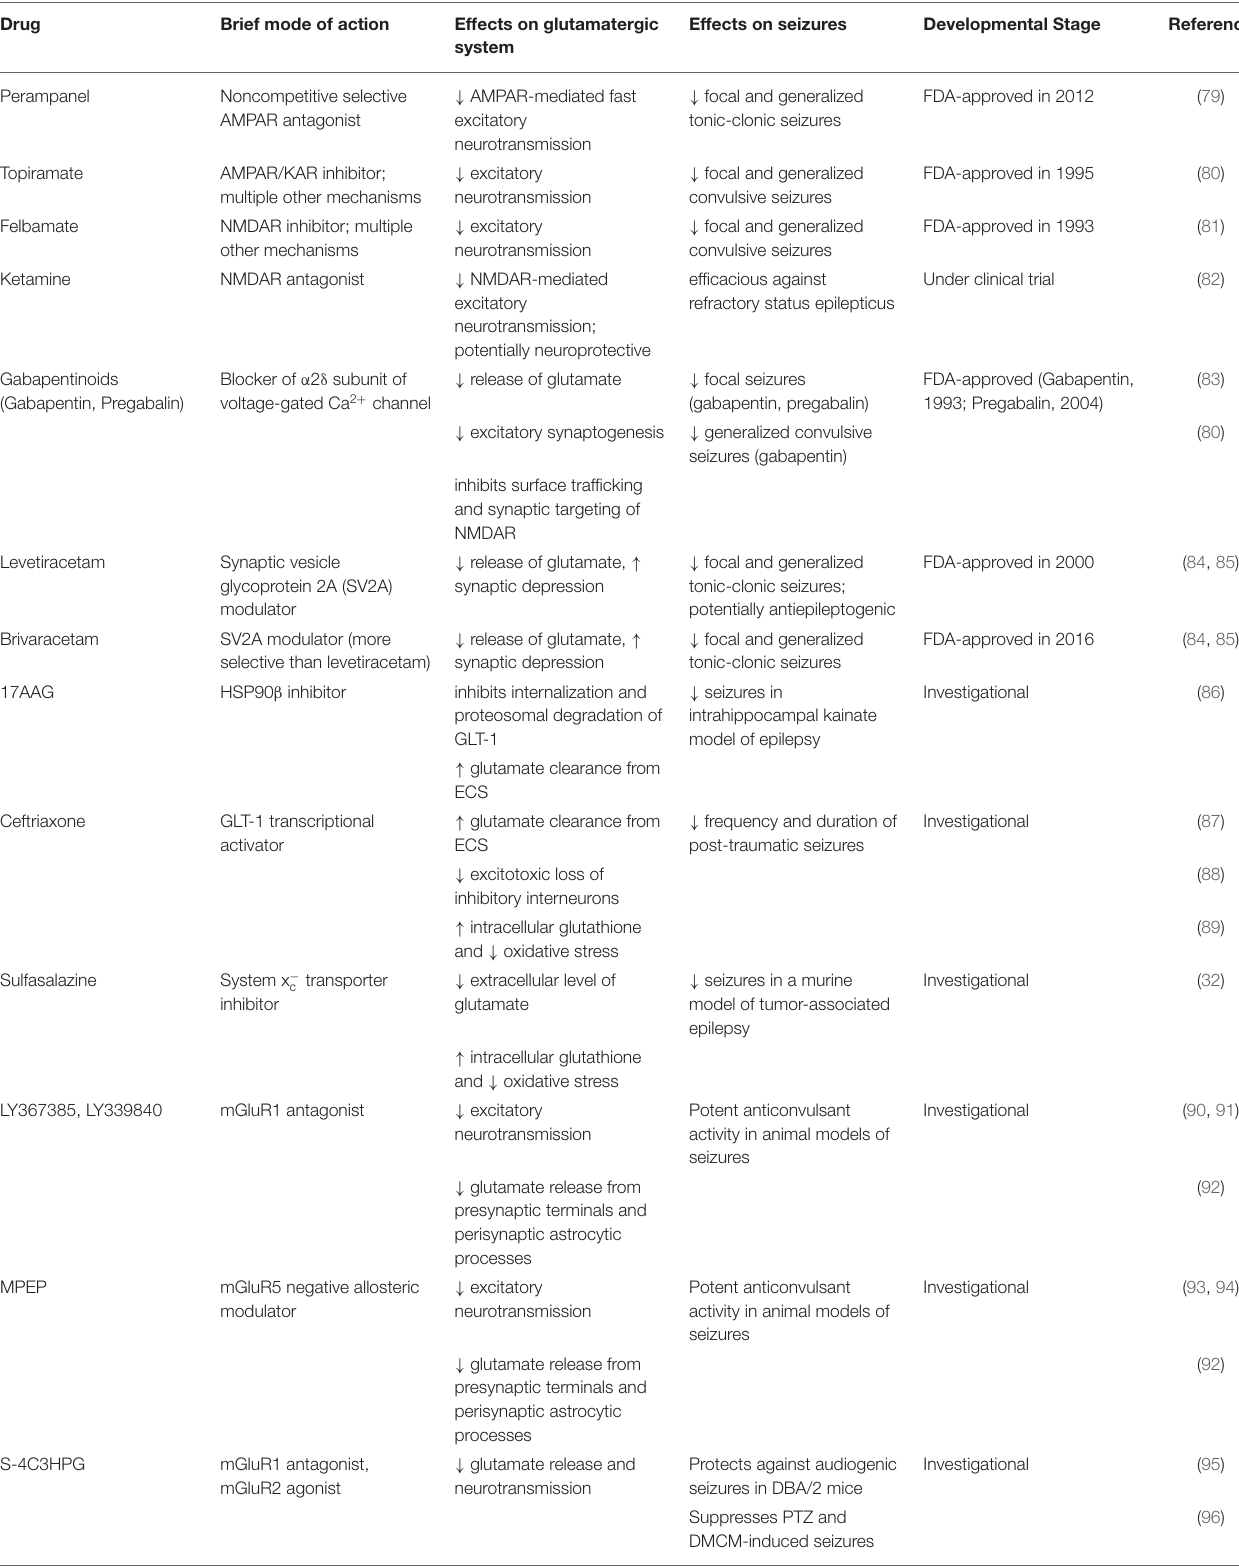
TABLE 1 | Pharmacotherapies targeting glutamate signaling for